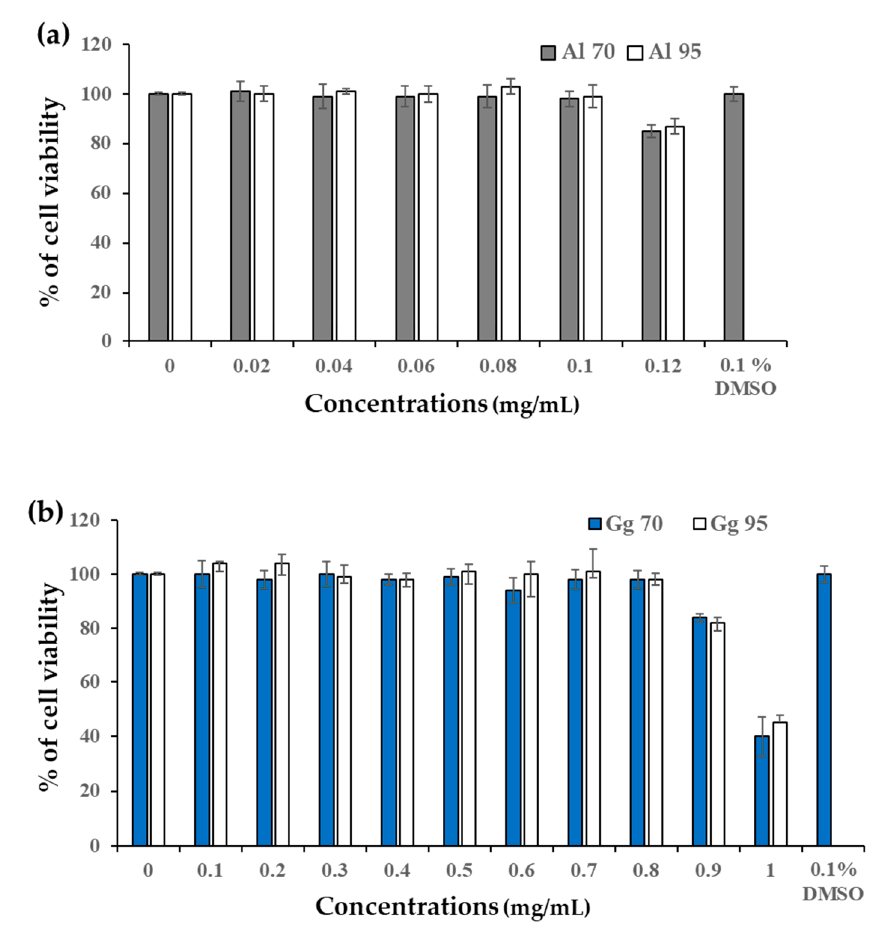
Figure 2. Viability of B16 cells exposed to A. lakoocha and G. glabra extracts. ( a ) A. lakoocha macerated in 70% (Al70) and 95% (Al95) of ethanol; and ( b ) G. glabra macerated in 70% (Gg70) and 95% (Gg95) of ethanol. Percentages of cell viability means ± SD from three independent